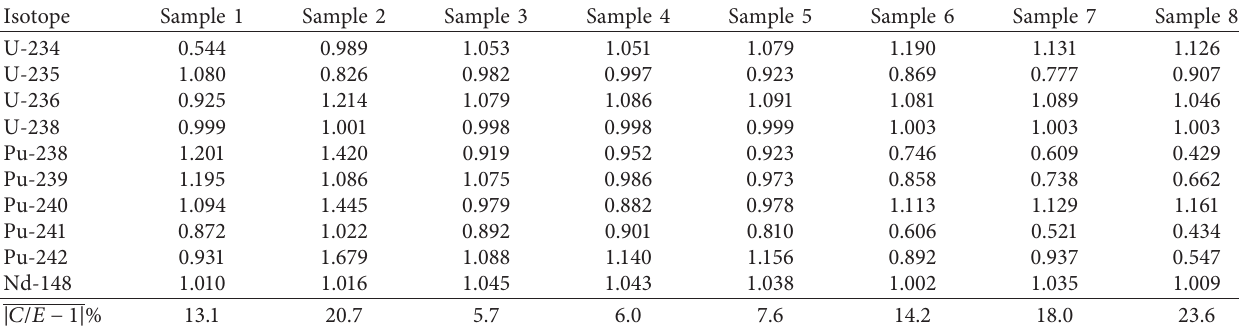
Table 1: Calculated/experimental (C/E) ratios for selected fuel isotopics in 2F2DN23/SF98.